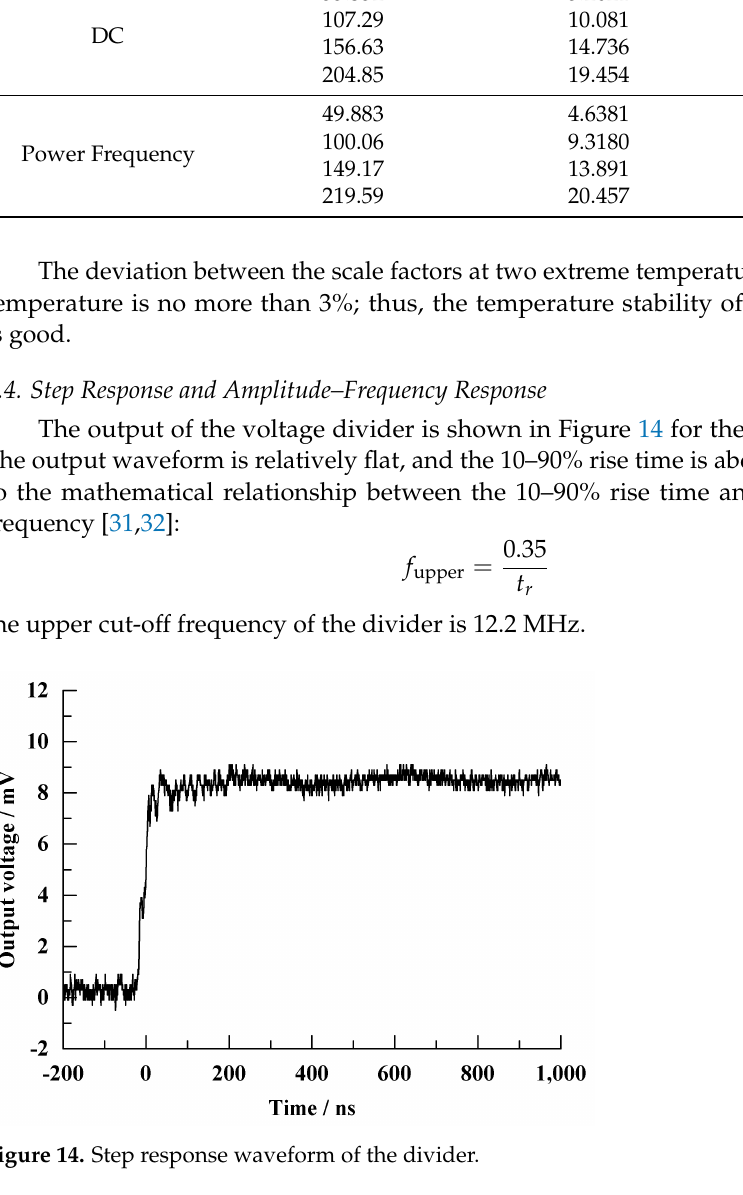
Figure 15. Amplitude – frequency characteristic curve of the divider. 6. Conclusions In this paper, a broadband resistive – capacitive parallel-connected voltage divider for transient voltage monitoring of a 220 kV power grid was developed. The main conclusions are as follows: (1) The internal electric field distribution of the voltage divider was optimized by using the structure of multi-stage series and multi-layer electrode plate shielding. The in- ductance of the high-voltage arm was reduced by adopting the circuit topology of multi-branch parallel connection, thus optimizing the response of the voltage di- vider. (2) The factors affecting the upper cut-off frequency were analyzed, and a method to increase the upper cut-off frequency was proposed based on the compensation resis- tor of the low-voltage arm.